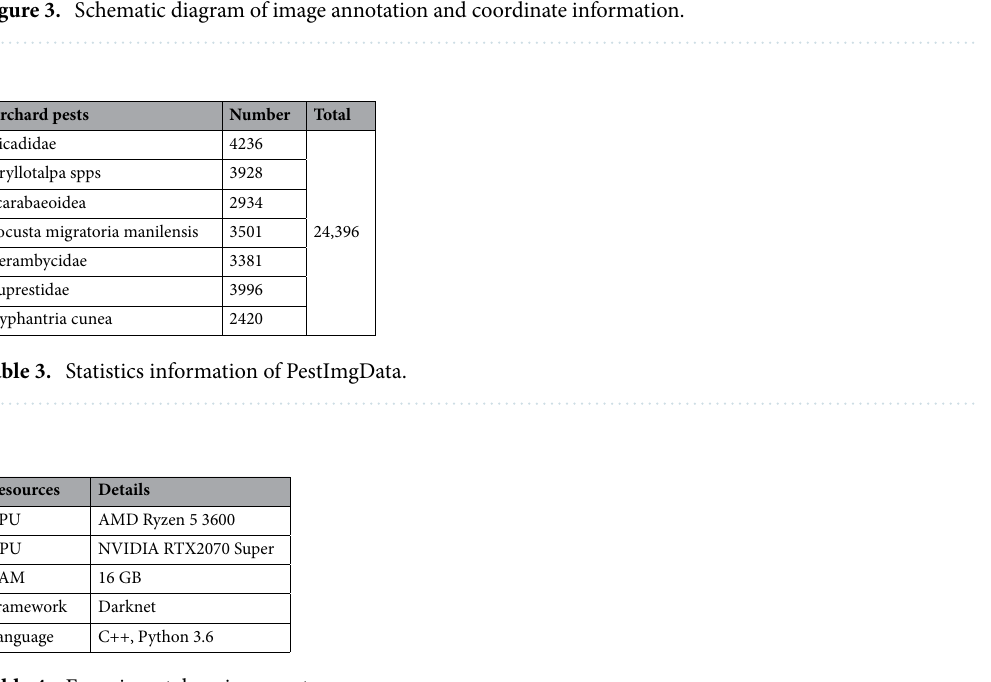
Table 4. Experimental